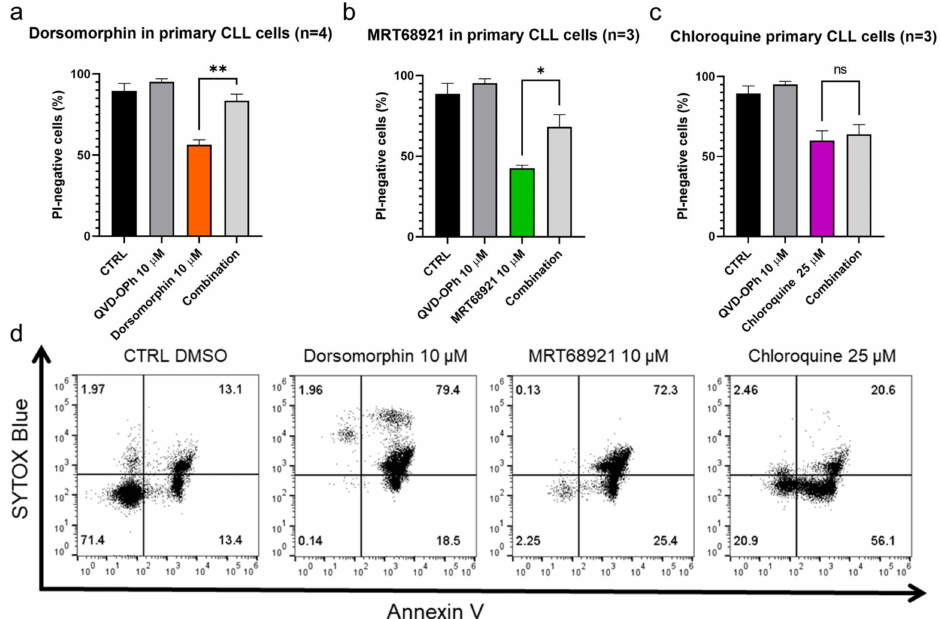
Figure 3. Autophagy inhibitors dorsomorphin, MRT68921, and chloroquine trigger apoptotic cell death in primary CLL cells. CLL cells (1 × 10 6 cells/mL) were treated with ( a ) dorsomorphin (n = 4), ( b ) MRT68921 (n = 3), and ( c ) chloroquine (n = 3) for 24 h without or with the pan-caspase inhibitor QVD-OPh. Afterward, cells were stained with propidium iodide (PI) and the cell viability was determined by flow cytometry. Data are means ± SEM of ≥ 3 independent experiments, each carried out in duplicate. Student’s t -test was used. Not significant (ns), ∗ , and ∗∗ denote p > 0.05, p < 0.05, and p < 0.01, respectively. ( d ) Representative dot plot diagram for phosphatidylserine exposure as a measure of cell death. Patient-derived cells were treated with dorsomorphin, MRT68921, and chloroquine for 24 h, followed by ANV/SB